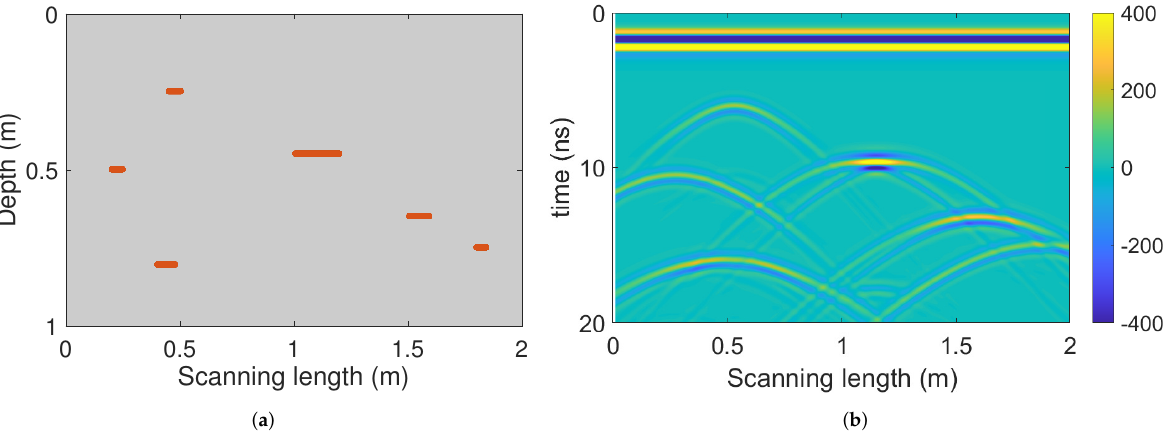
Figure 4. ( a ) Subterranean model with 6 cracks; ( b ) The pre-processed radargram. Firstly, the radargram is decomposed by 2D SWT, and Figure 5 illustrates the 2nd layer